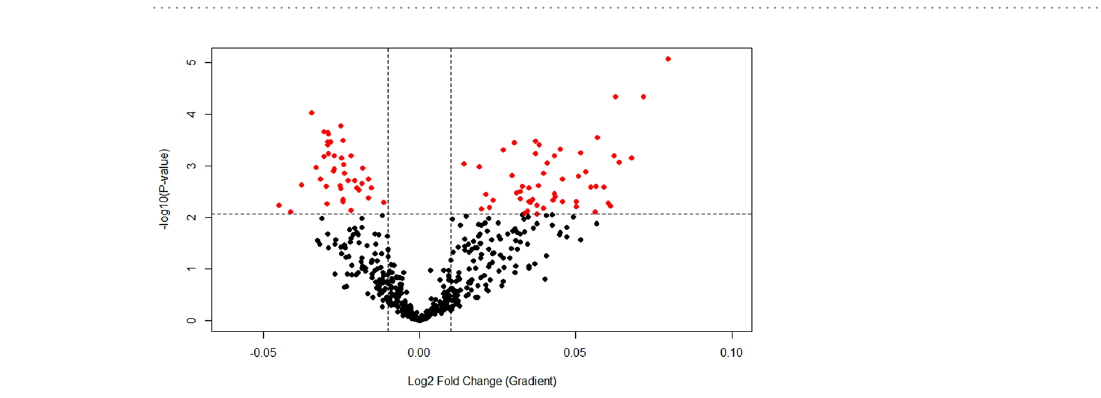
Table 1. Median, mean and range of the exposure to the individual POPS and the cumulative Z-Score.